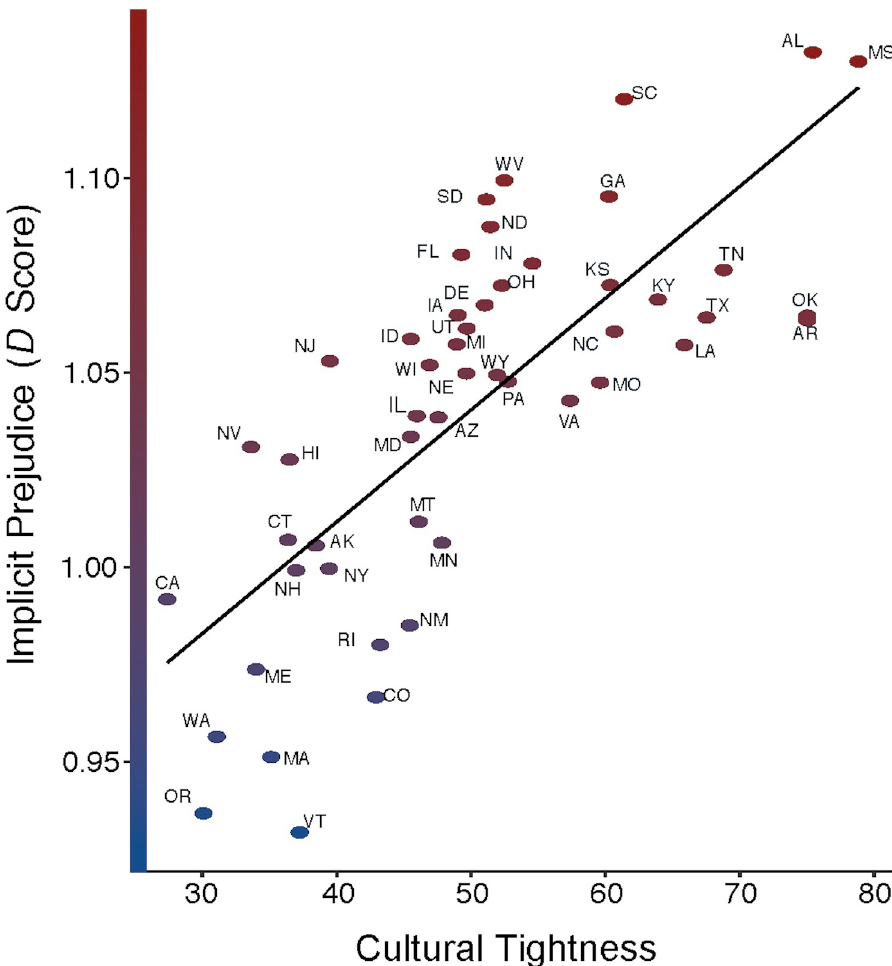
Fig 3. The relationship between cultural tightness and implicit prejudice. Implicit prejudice has been standardized in this figure.